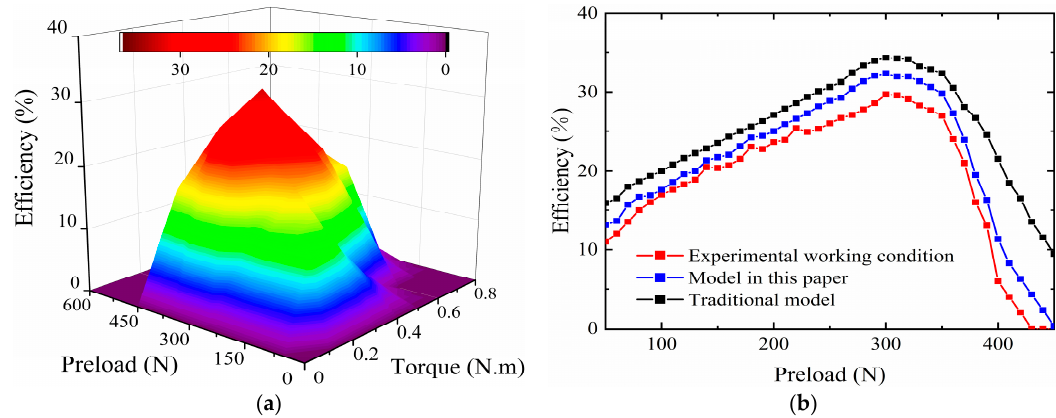
Figure 9. Motor output efficiency: ( a ) Experimental results of preload–load torque–output efficiency; ( b ) Comparison of output efficiency for a load torque of 0.2 N.m.